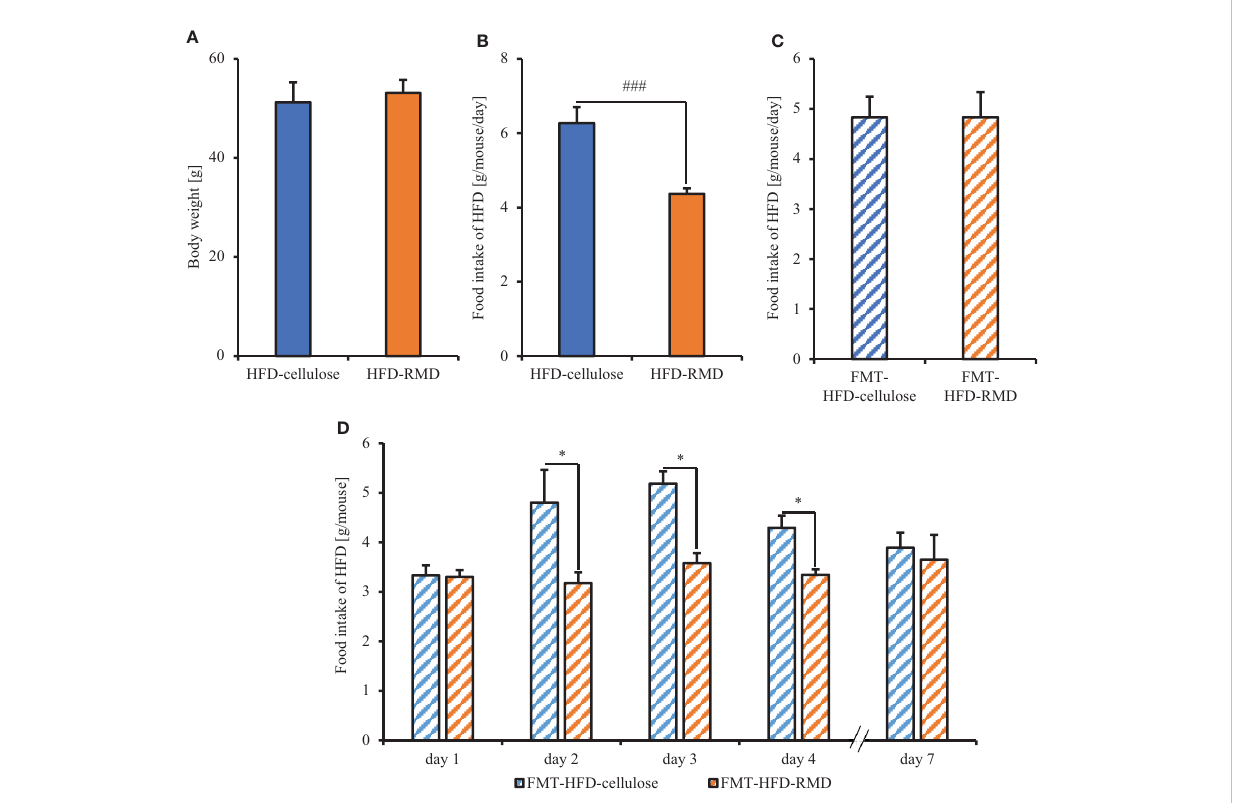
FIGURE 6 Food intake of mice transplanted with fecal microbiota from mice fed with HFD supplemented with or without RMD. (A, B) Body weight and average each food intake level in the FMT-donor mice before the FMT-treatment. We kept both groups under each feeding condition for more than 8 weeks and measured the food intake 1 week before the FMT. (C) Average HFD-cellulose intake levels in the FMT-recipient mice before the FMT-treatment for 2 days before the FMT. (D) Change in average food intake of HFD-cellulose during each day. Data are presented as the mean ± SEM (the HFD- cellulose and HFD-RMD groups, n = 8; the FMT-HFD-cellulose group, n = 7; the FMT-HFD-RMD group, n = 8). * p < 0.05 (Mann Whitney test with false discovery rate multiple testing correction). ### p < 0.001 (Mann Whitney